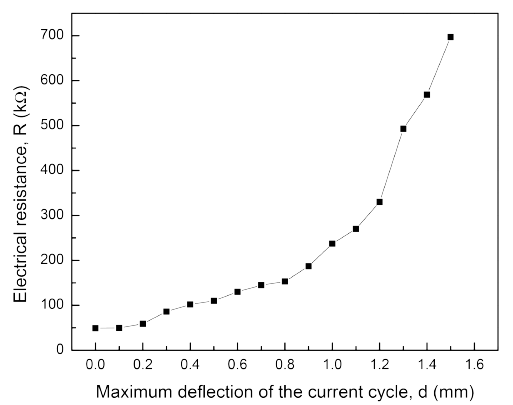
Figure 8: Resistance variations, ∆R , with respect to the strain, ε f , at the end of each displacement cycle